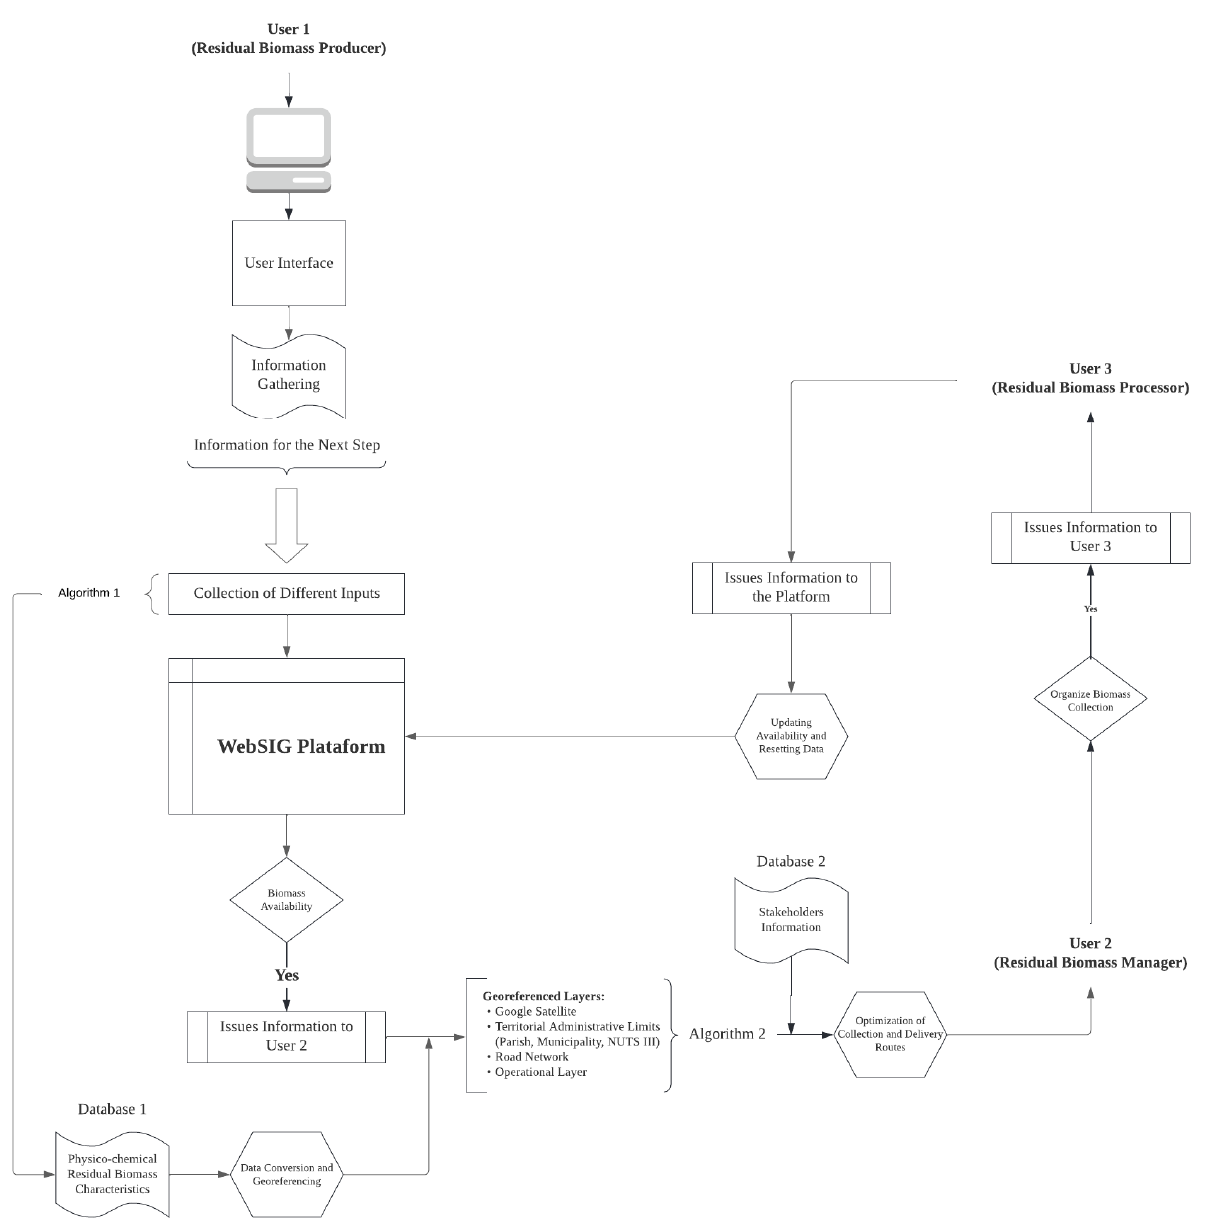
Figure 5. Operational framework of the residual biomass management platform to support the BioAgroFloRes project.